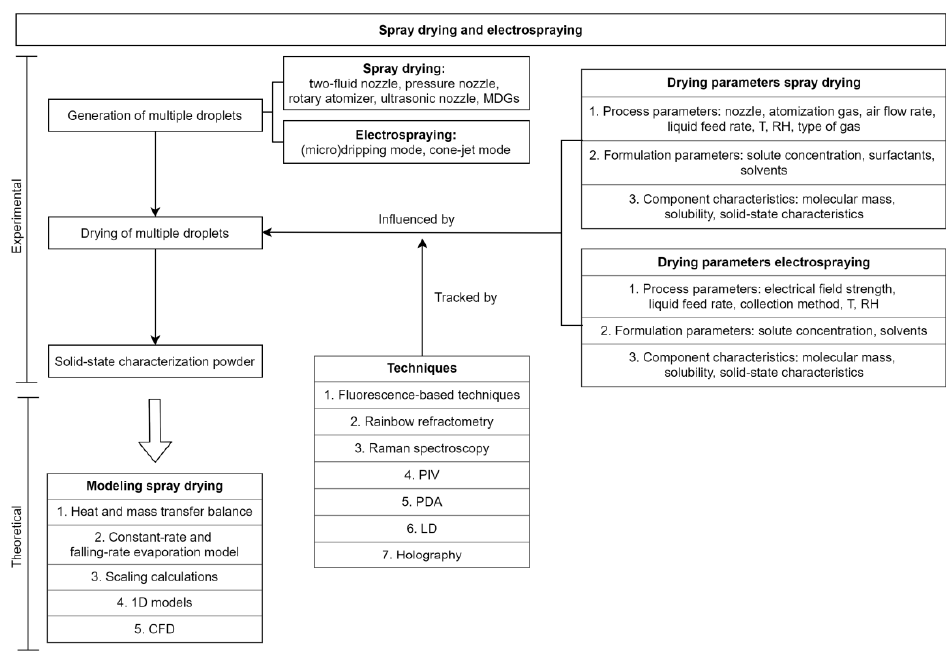
Figure 12. Flow chart spray drying and electrospraying.